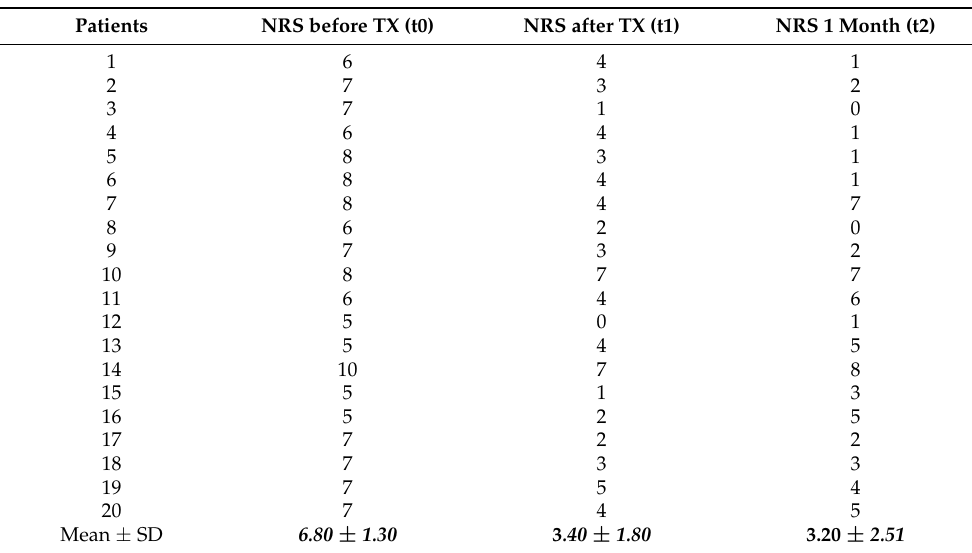
The NRS scores measured before treatment (t0), after treatment (t1) and at the 1- month follow up (t2) are reported in Table 3. Table 3. Numerical Rating Scale (NRS) scores. The before treatment (t0) NRS scores are reported in the first column, the after treatment (t1) NRS scores are in the second column and the NRS scores at the 1-month follow up (t2) are reported in the third column. TX = treatment.